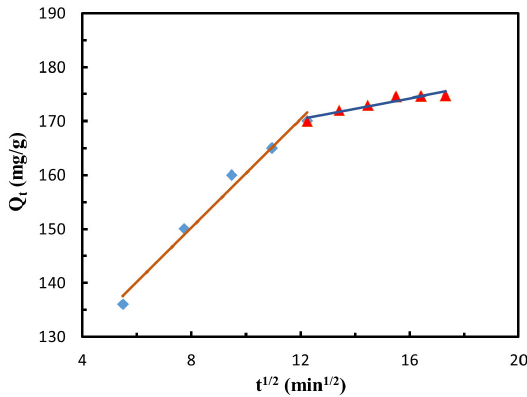
Figure 13. Fitting diagram of the IPD model in the MB adsorption process.